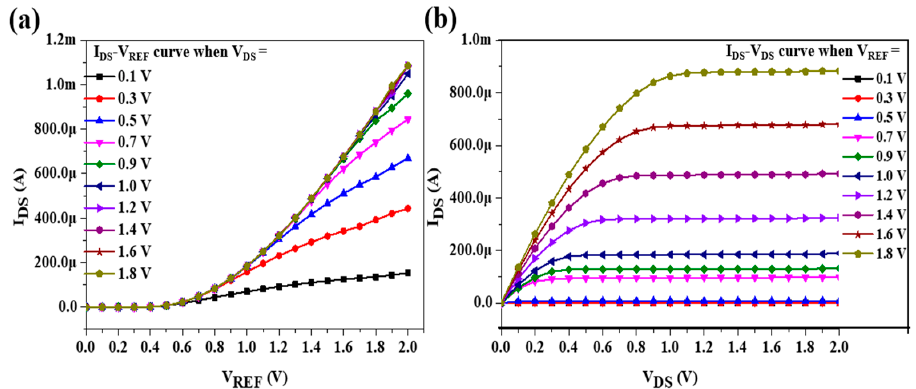
Figure 7. Transmission characteristics of EGFET at different stationary voltages. ( a ) I DS –V REF transfer curve; ( b ) I DS –V DS transfer curve.